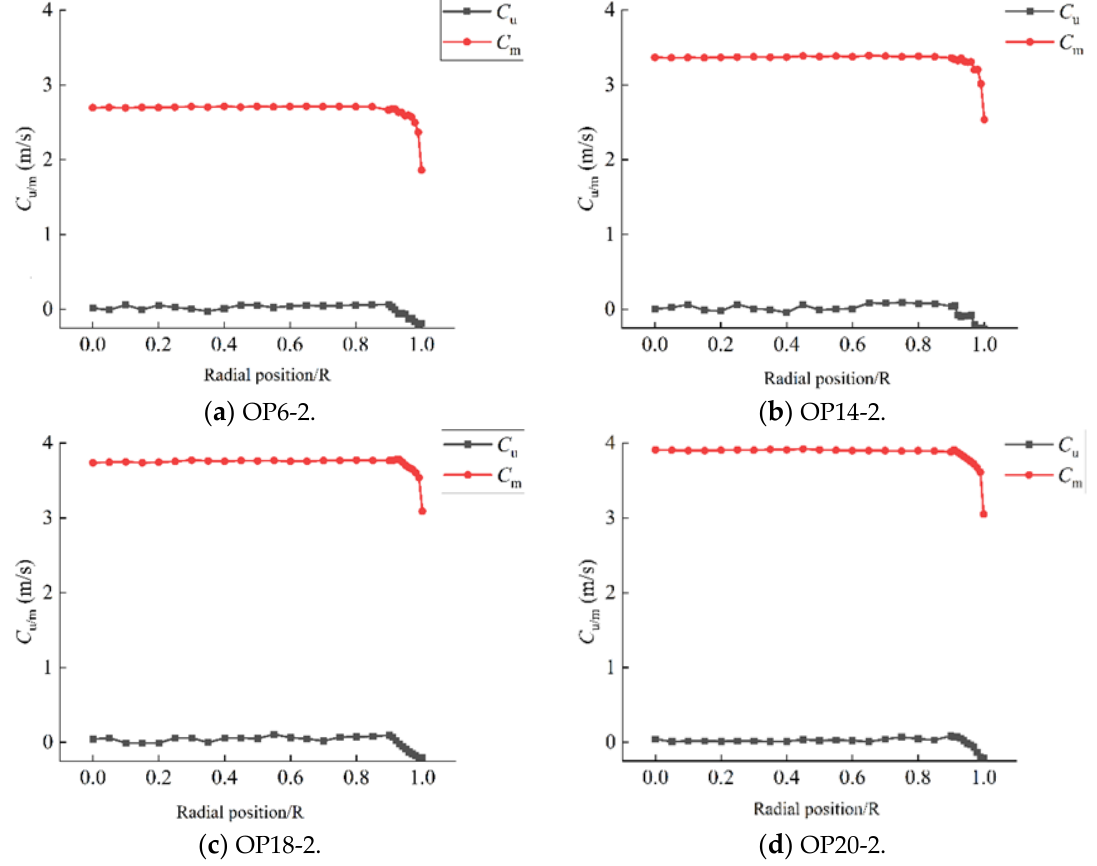
Figure 11. Average tangential velocity and axial velocity in pump mode.